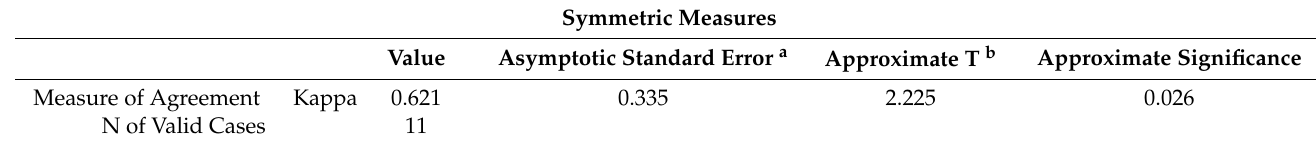
Table 3. Agreement studies included in the qualitative synthesis percentage and kappa result between first and second